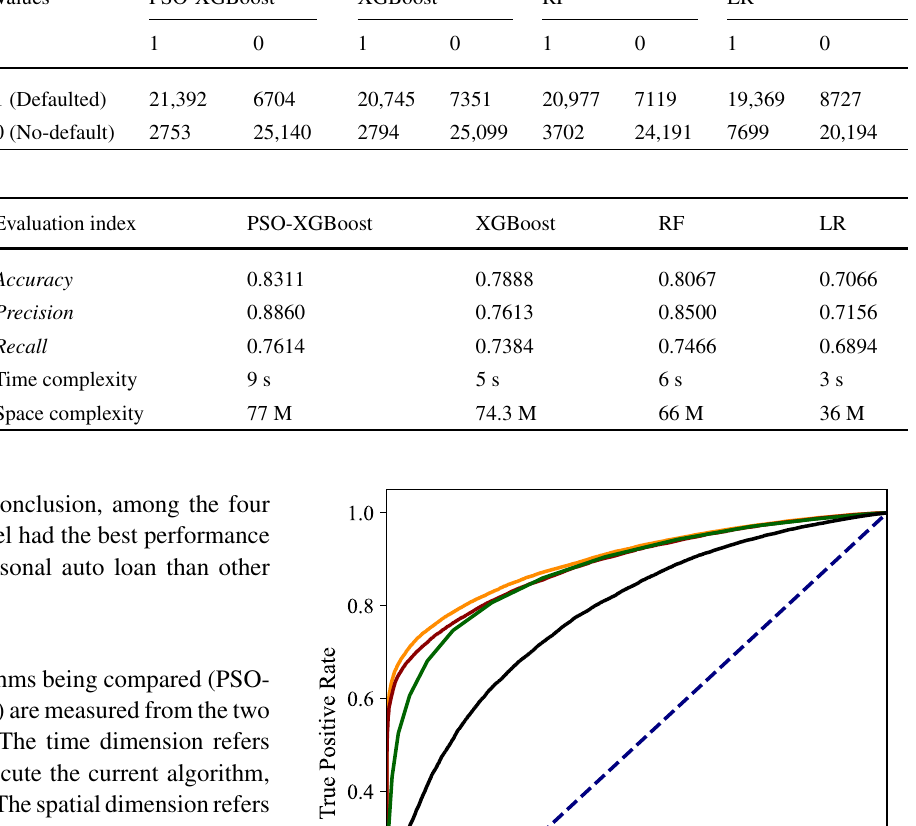
Table 11 Model comparison by confusion matrix Values